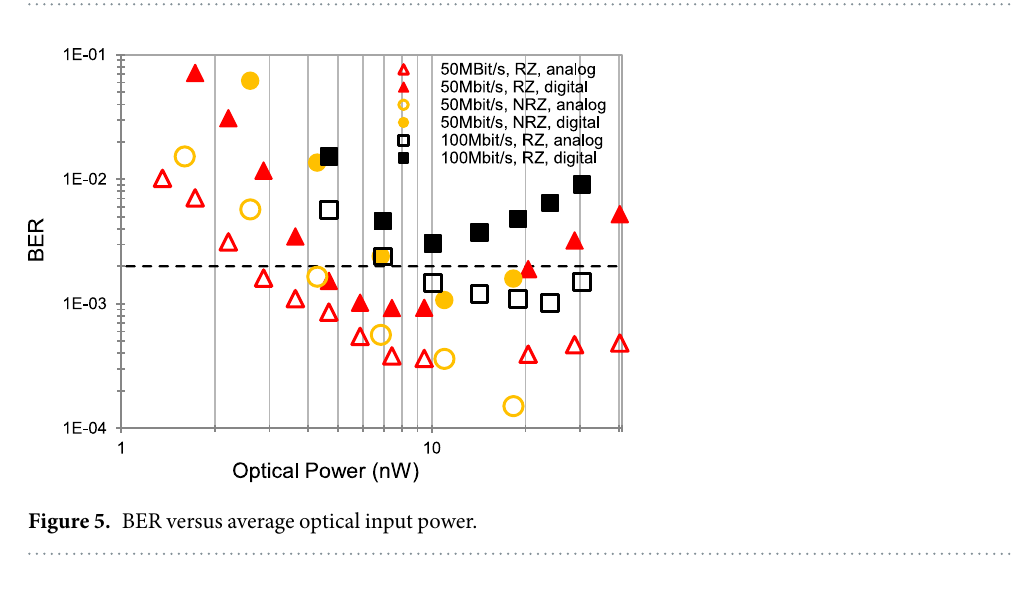
Figure 4. Bit error rate for an optical input power of 7.5 nW.